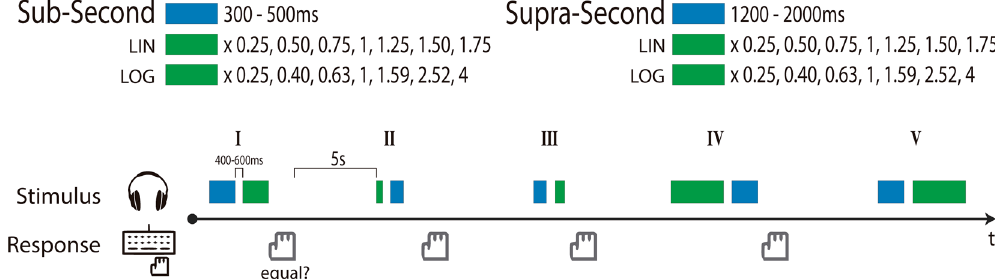
Figure 1. Diagram of the experimental paradigm. Blue rectangles represent Standard durations and green rectangles represent Comparison durations. Linearly spaced proportions (LIN) were used in Experiments 1 and 2 and logarithmically spaced proportions (LOG) in Experiment